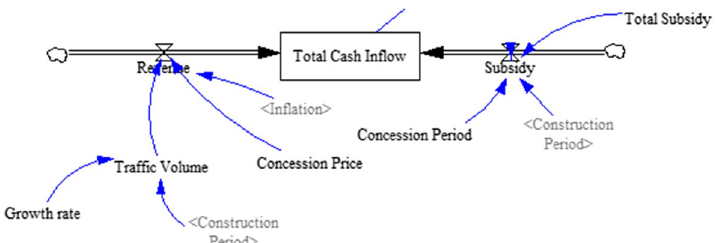
Fig. 5 Stock and flow diagram for the total cash